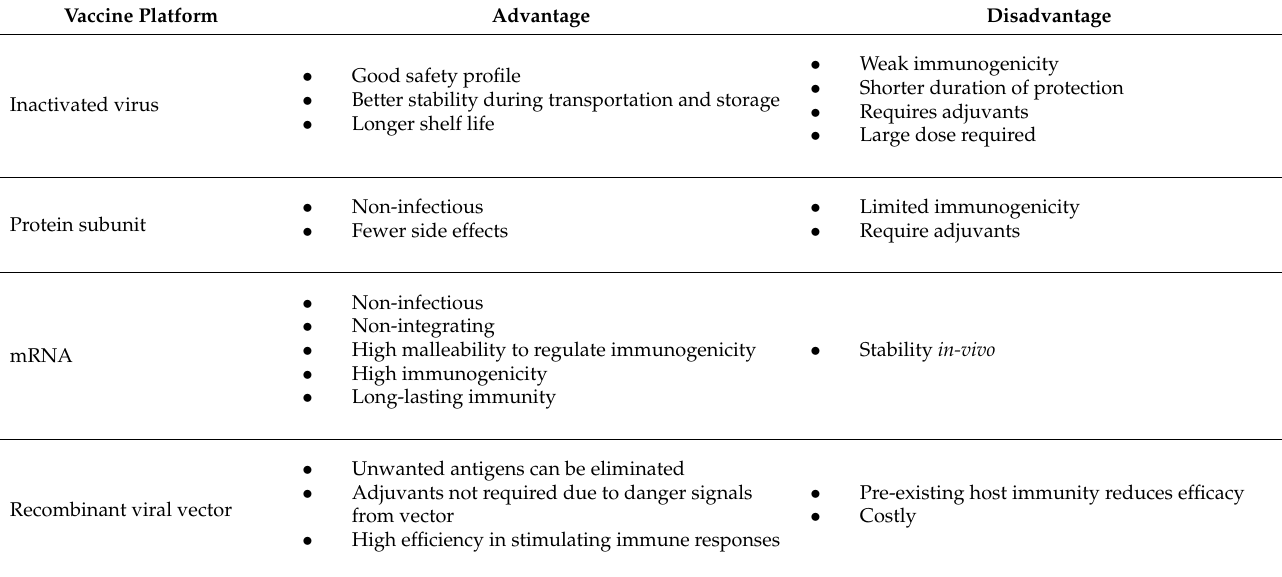
Table 3. Advantages and disadvantages of various vaccine